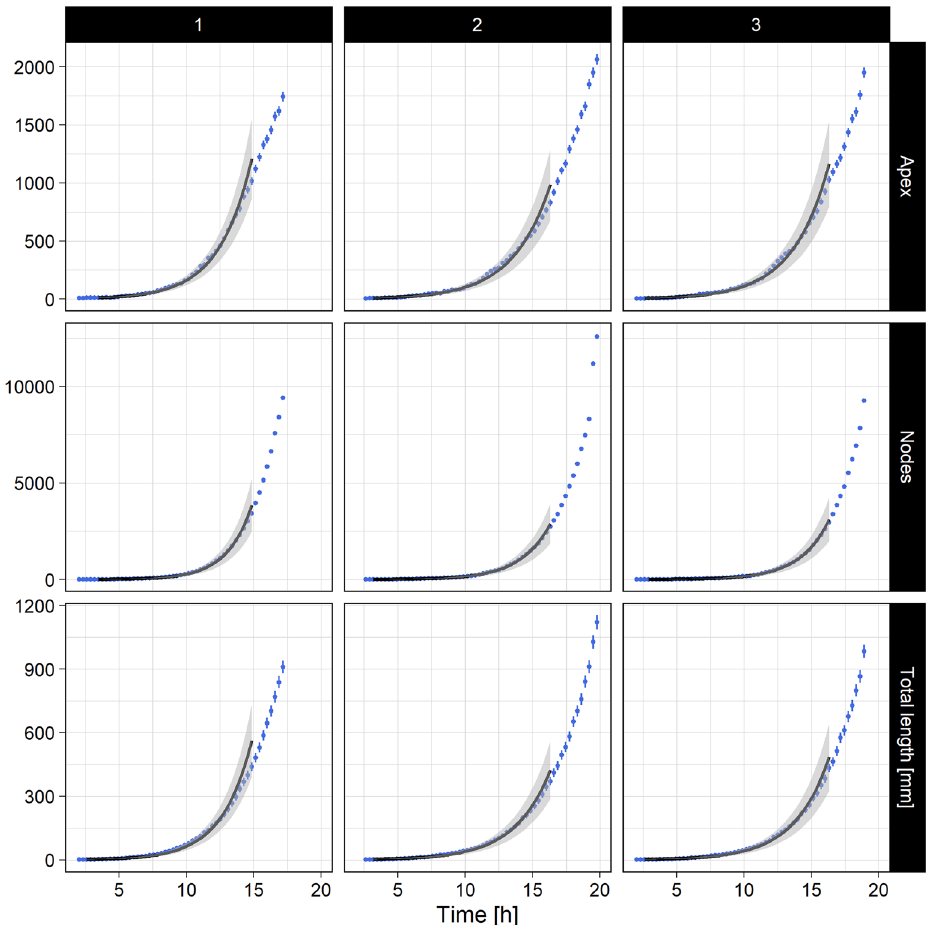
Figure 10. Number of apexes N V 1 ob , Number of nodes N V 3 ob and total length L as a function of time t for the experiments (1) (left), (2) (middle) and (3) (right). Experimental data (blue) are shifted in time of respective t 0 . Solid black lines represent the best fit parameters (see Table 2). The respective grey shadowing wraps the data range used to perform to statistical fit, while its thickness quantifies the associated uncertainties to one standard